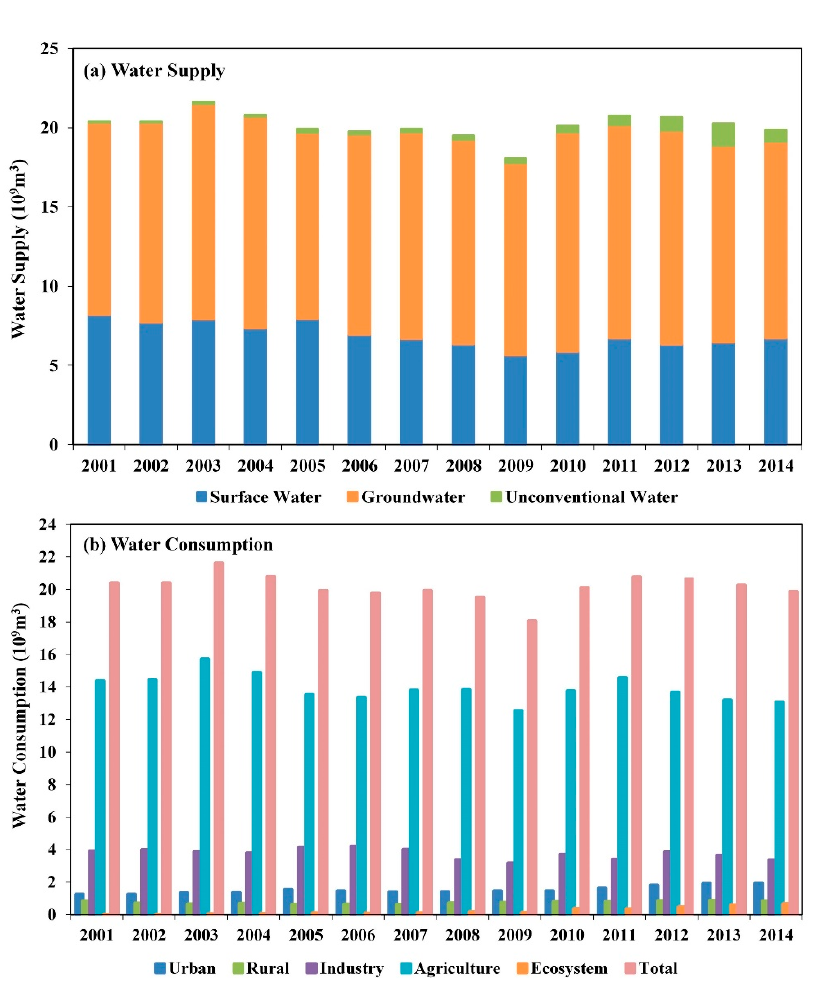
Figure 4. ( a ) Water supply and ( b ) water consumption in the YD River Basin from 2001 to 2014.